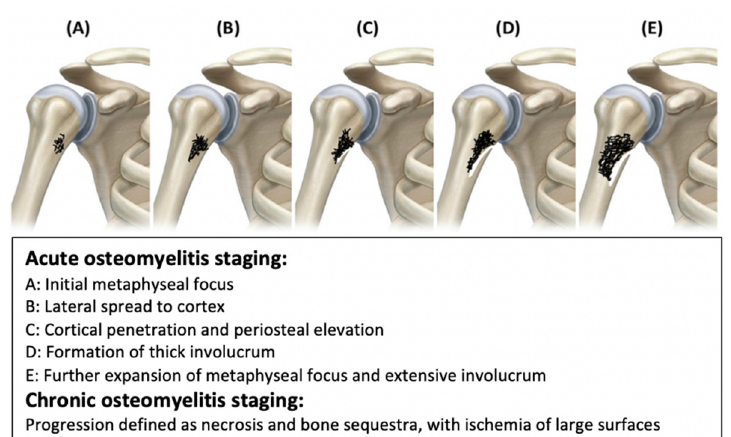
Figure 2. Progression of either ( A ) acute or ( B ) chronic osteomyelitis ( C ) Cortical penetration and periosteal elevation ( D ) Formation of thick involucrum ( E ) Further expansion of methaphyseal focus and extensive involucrum. Two significant differences between acute and chronic osteomyelitis should be noted: the formation of a biofilm and the infiltration of the bacteria into host cells, both of which happen in chronic osteomyelitis. Modified from Desimpel et al.